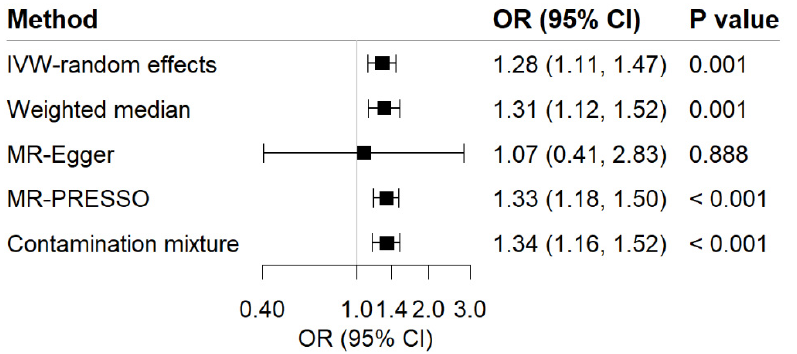
Figure 4. Associations of GERD with risk of MDD in MR analyses. The ORs of MDD were scaled to a 1-unit increase in log OR of GERD. IVW, inverse variance weighted; OR, odds ratio; CI, confidence interval; MR, Mendelian randomization.